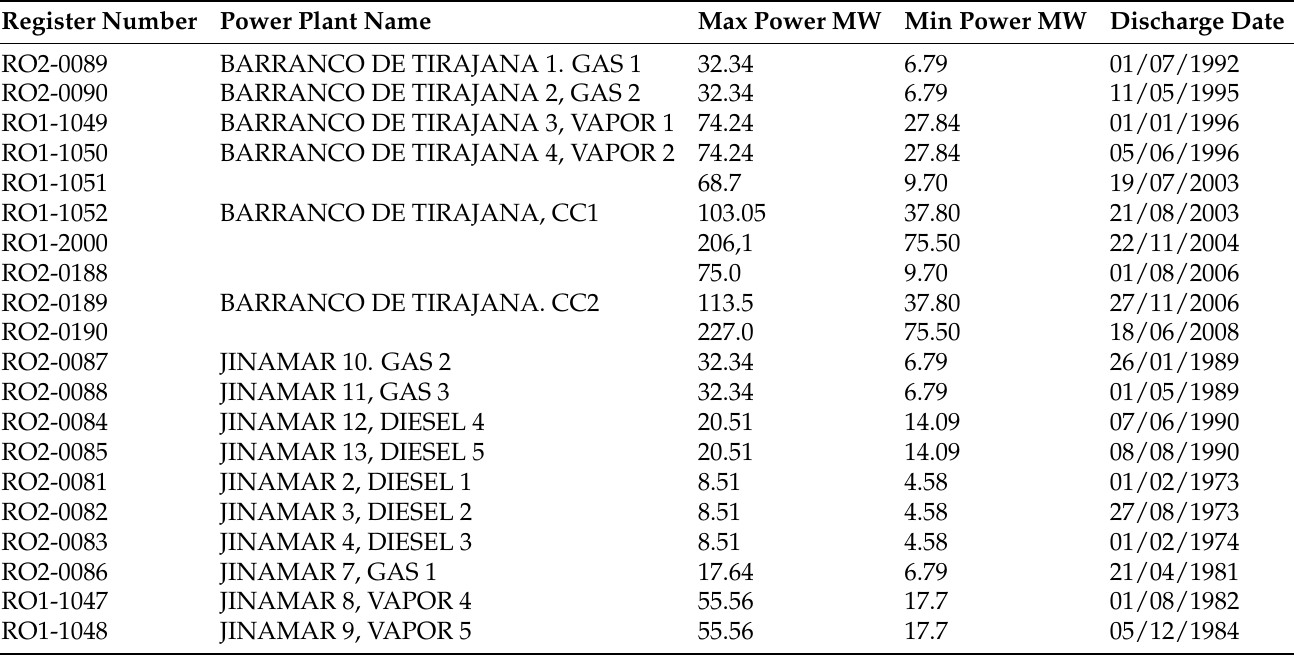
Table 2. Gran Canaria generation